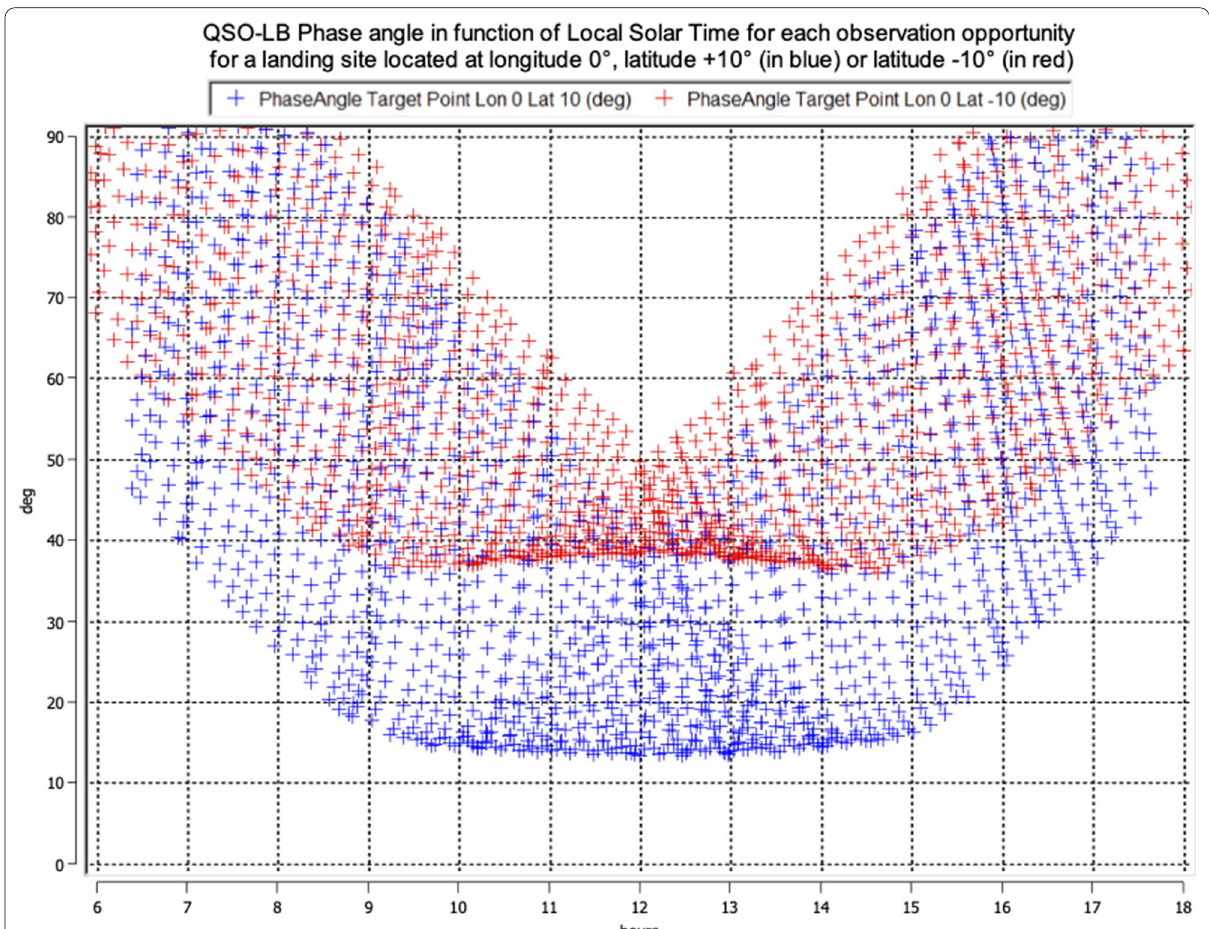
Fig. 10 QSO‑LB phase angle distribution as a function of local solar time for each observation opportunity for a landing site located at longitude 0° and latitude 10° (in blue) or latitude 10° (in + −